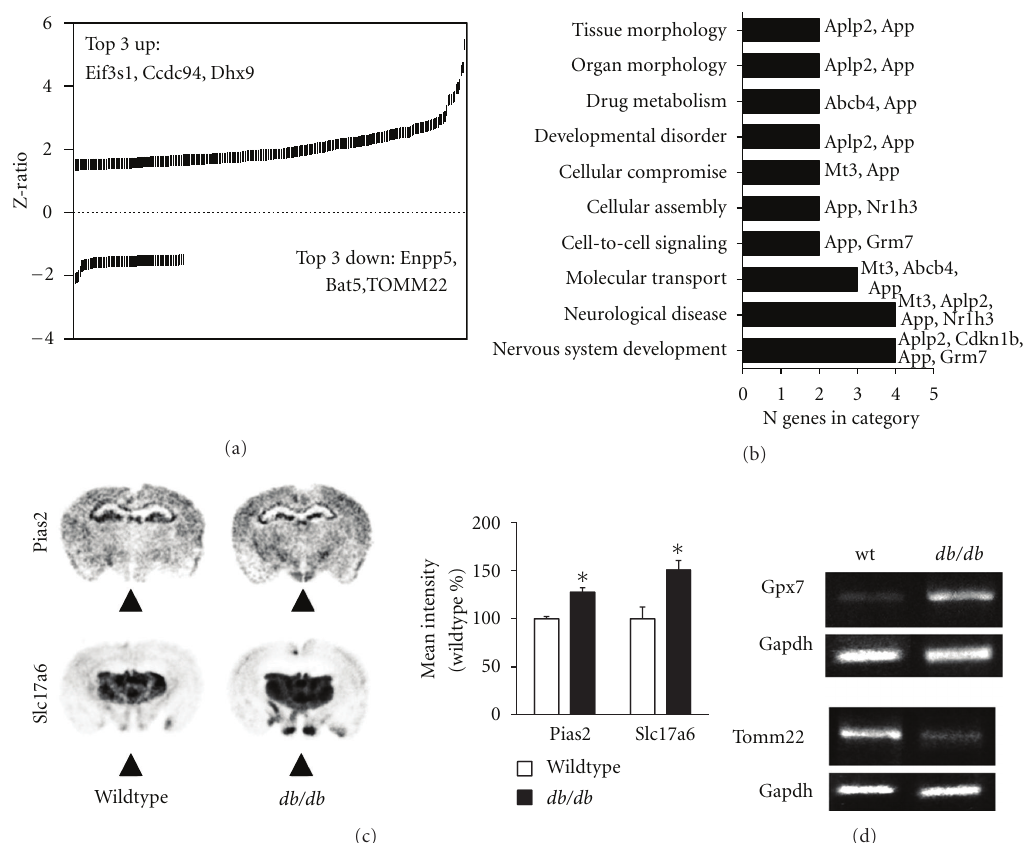
Figure 3: Di ff erences in hypothalamic gene expression and pathway recruitment between C57Bl/6 and db/db mice under ad libitum, sedentary conditions. (a) Graph of Z-ratios showing that di ff erences in gene expression between C57Bl/6 and db/db mice are primarily attributable to transcriptional upregulation, as opposed to down-regulation. Abbreviations: Eif3s1, eukaryotic translation initiation factor 3, subunit J; Ccdc94, coiled-coil domain containing 94; Dhx9, DEAH (Asp-Glu-Ala-His) box polypeptide 9; Enpp5, ectonucleotide pyrophosphatase/phosphodiesterase 5; Bat5, HLA-B associated transcript 5; Tomm22, translocase of outer mitochondrial membrane 22. (b) Pathways that di ff er between wild-type and db/db mice under ad libitum , sedentary conditions. Aplp2, amyloid beta (A4) precursor-like protein 2; App, amyloid beta precursor protein; Abcb4, ATP-binding cassette, subfamily B member 4; Mt3, metallothionein 3; Nr1h3, nuclear receptor subfamily 1, group H, member 3; Grm7, glutamate receptor, metabotropic 7; Cdkn1b, cyclin-dependent kinase inhibitor 1B. (c) Pias2 and Slc17a6 expression in C57Bl/6 and db/db mice under ad libitum , sedentary conditions. Arrowheads indicate the hypothalamic nuclei, which were traced over the rostrocaudal extent of the hypothalamus to generate an average index of gene expression that would be directly comparable to the microarray analysis conducted in whole-hypothalamus RNA extracts. Pias2, protein inhibitor of activated STAT 2; Slc17a6, solute carrier family 17 member 6. Associated graph indicating densitometric results of the expression analysis. Consistent with the microarray results, both Pias2 and Slc17a6 were significantly upregulated in the hypothalamus of db/db mice. Asterisk ( ∗ ) indicates statistical significance at P < 0 . 05 following bidirectional student’s t -tests. (d) Further validation through semiquantitative PCR reveals that, as shown by the microarray, Gpx7 mRNA is increased and Tomm22 mRNA is reduced in the hypothalamus of db/db mice.